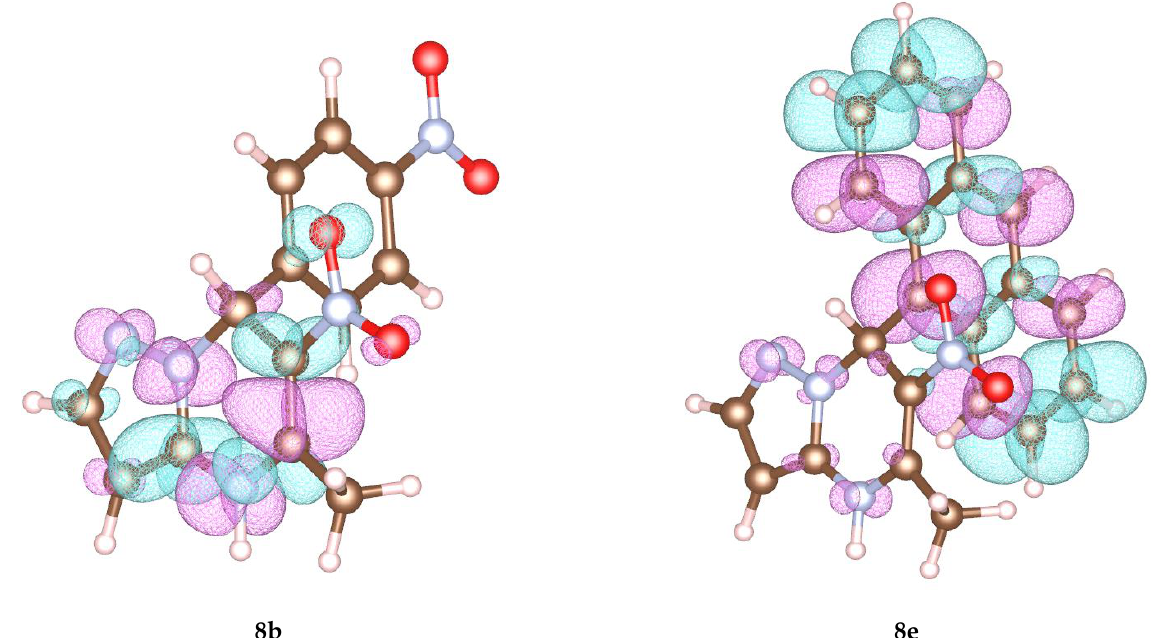
Figure 2. Visualization of HOMO for compounds 8b and 8e obtained in PBE0 approximation.